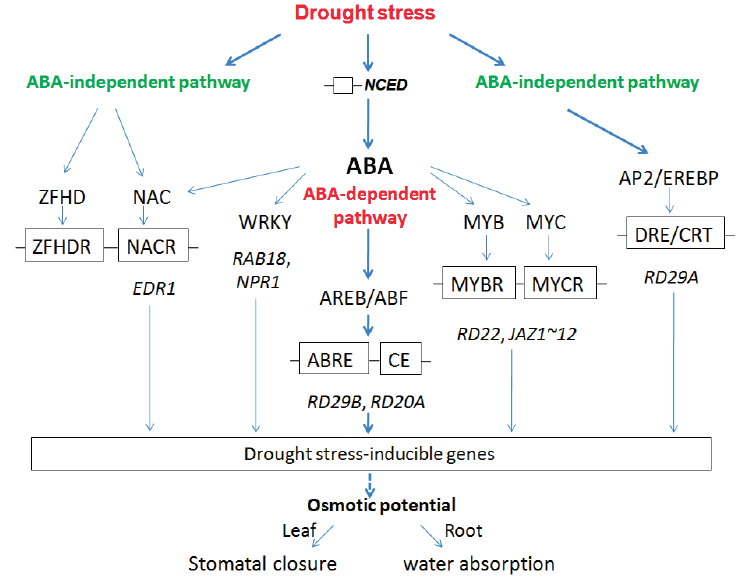
Figure 8. Proposed model for drought stress mechanism of root and leaf in B. napus